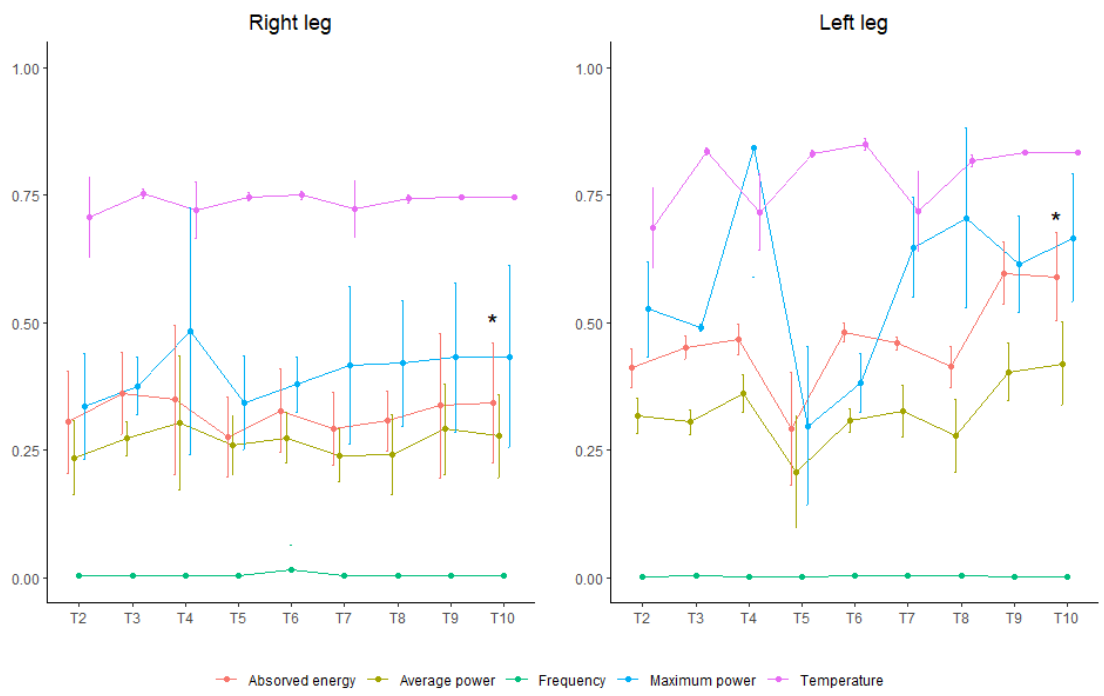
Figure 2. Radiofrequency parameters (standardized adjusted mean and standard deviation error bars). * Radiofrequency parameter significant differences between both legs.